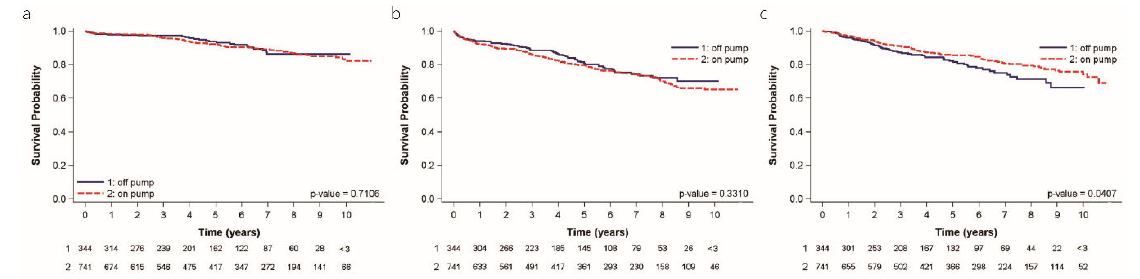
Figure 2. Kaplan–Meier survival curve. ( a ) All cause of death in both groups. The 5-year survival rate was 93.9% in the off-pump and 92.2% in on-pump groups; the 10-year survival rate was 86.3% in the off-pump and 82.1% in the on-pump groups. ( b ) Major cardiac and cerebrovascular events (death, myocardial infarction, and stoke). The 5-year free from major adverse cardiac and cerebrovascular events (MACCE) rate was 79.1% in the off-pump and 81.8% in the on-pump groups; the 10-year free from MACCE rate was 64.8% in the off-pump and 70.0% in the on-pump groups. ( c ) Kaplan–Meier survival curve of repeat revascularization. Off-pump carries concern of repeat revascularization in the long term. Free from revascularization at 5 years was 86.2% in on-pump vs. 80.8% in off-pump, and at 10 years, 76.1% vs. 65.9%,